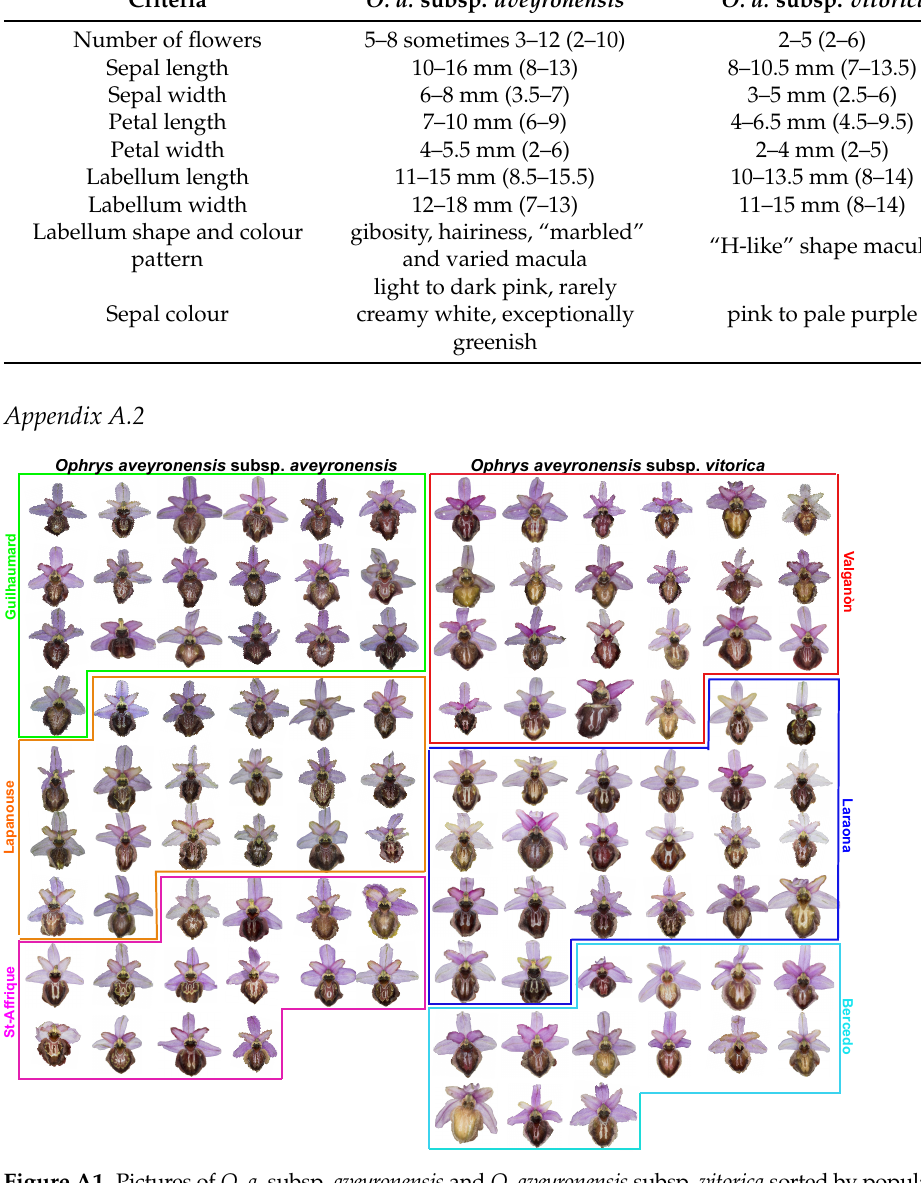
Figure A1. Pictures of O. a. subsp. aveyronensis and O. aveyronensis subsp. vitorica sorted by